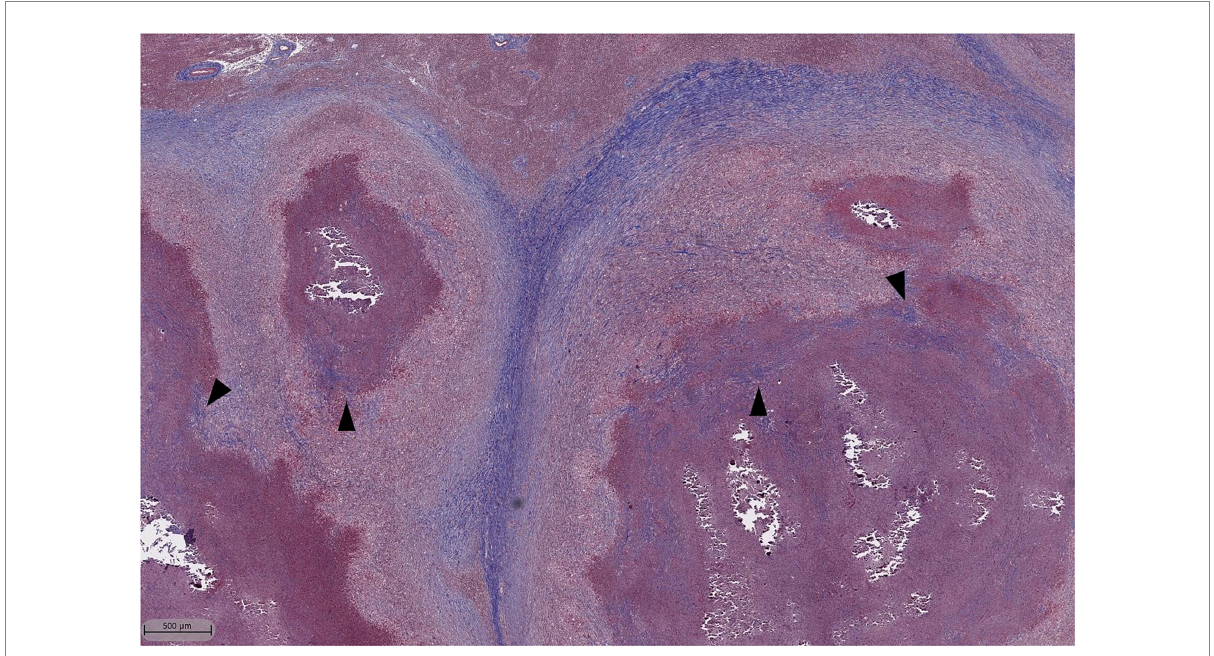
FIGURE 8 Masson’s Trichrome stain of lymph node granulomas of cattle infected with M. bovis . Dark blue staining represents collagen which is found prominently surrounding the granulomas. Additionally, there are areas of centralized fibrosis throughout and immediately next to areas of necrosis